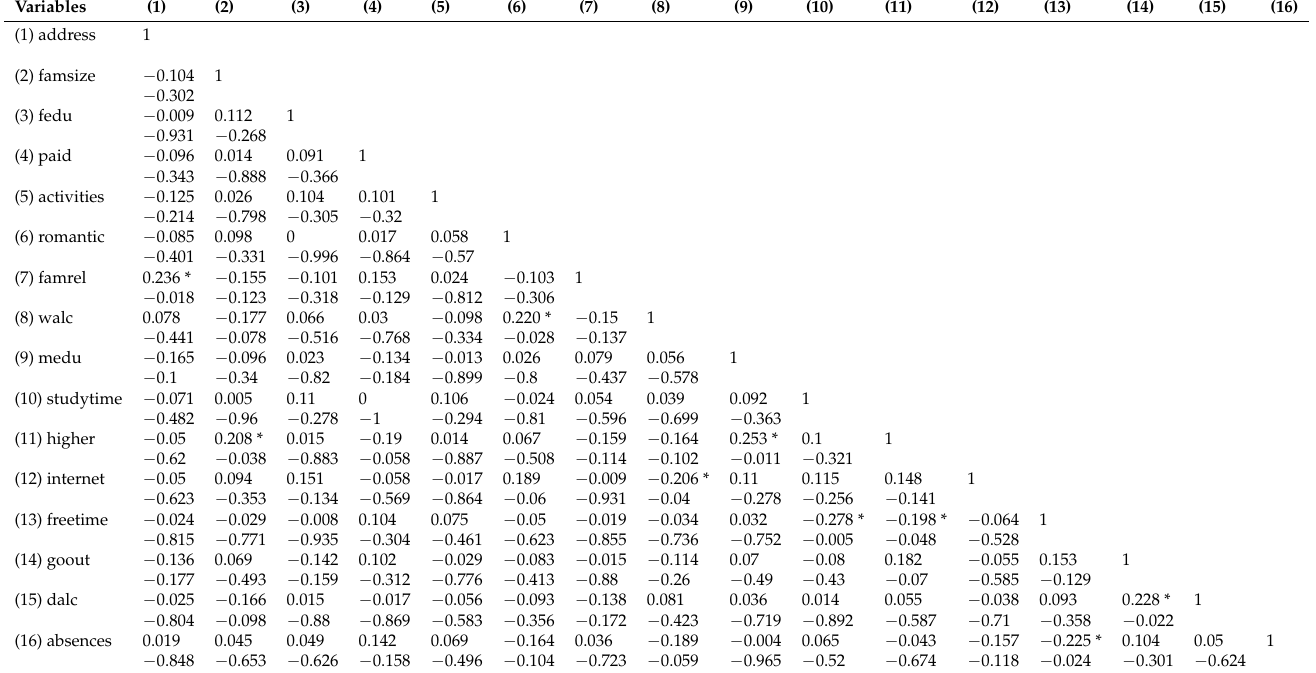
Table 3. Results of significance test of pairwise